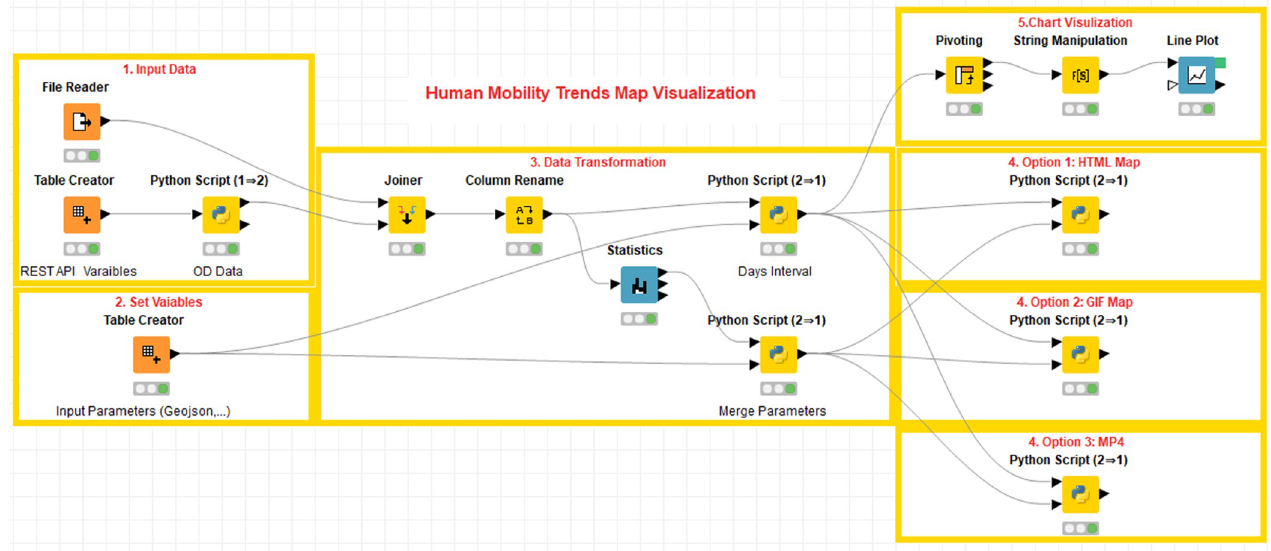
Fig 9. The workflow of human mobility intensity trends